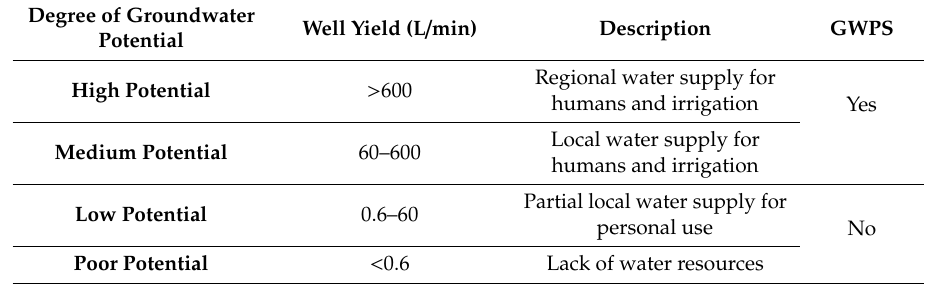
Table 3. Classifications of groundwater potential and groundwater potential sites (GWPS) (after [63]).